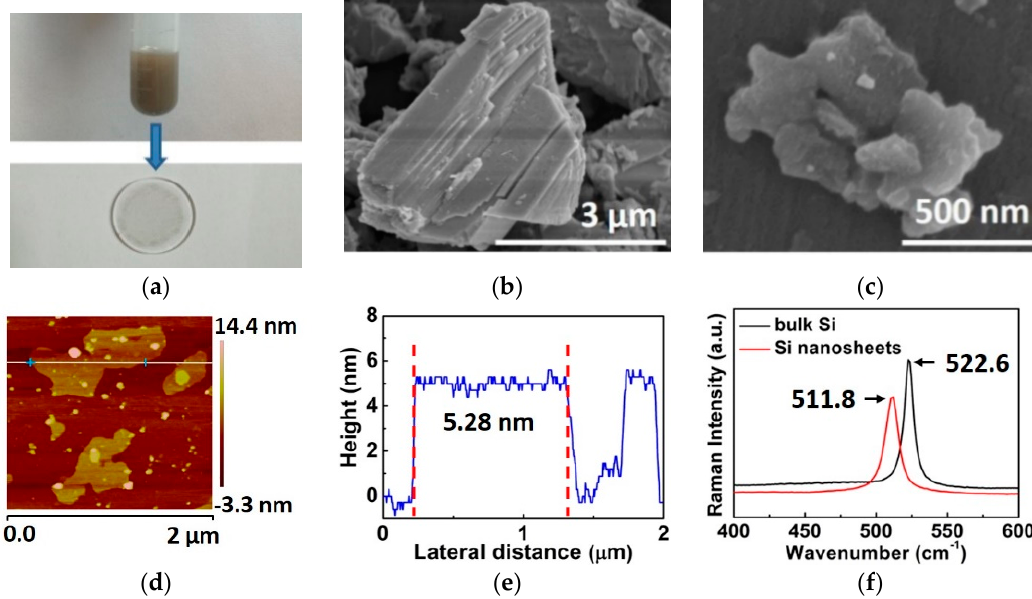
Figure 1. ( a ) Photographs of the Si nanosheet dispersion and the Si nanosheets coated on quartz substrate. ( b ) Scanning electron microscope (SEM) image of Si powder and ( c ) SEM image of Si nanosheets. ( d , e ) Atomic force micrsocope (AFM) image and corresponding height profile of Si nanosheets. ( f ) Raman spectra of bulk Si and Si nanosheets.